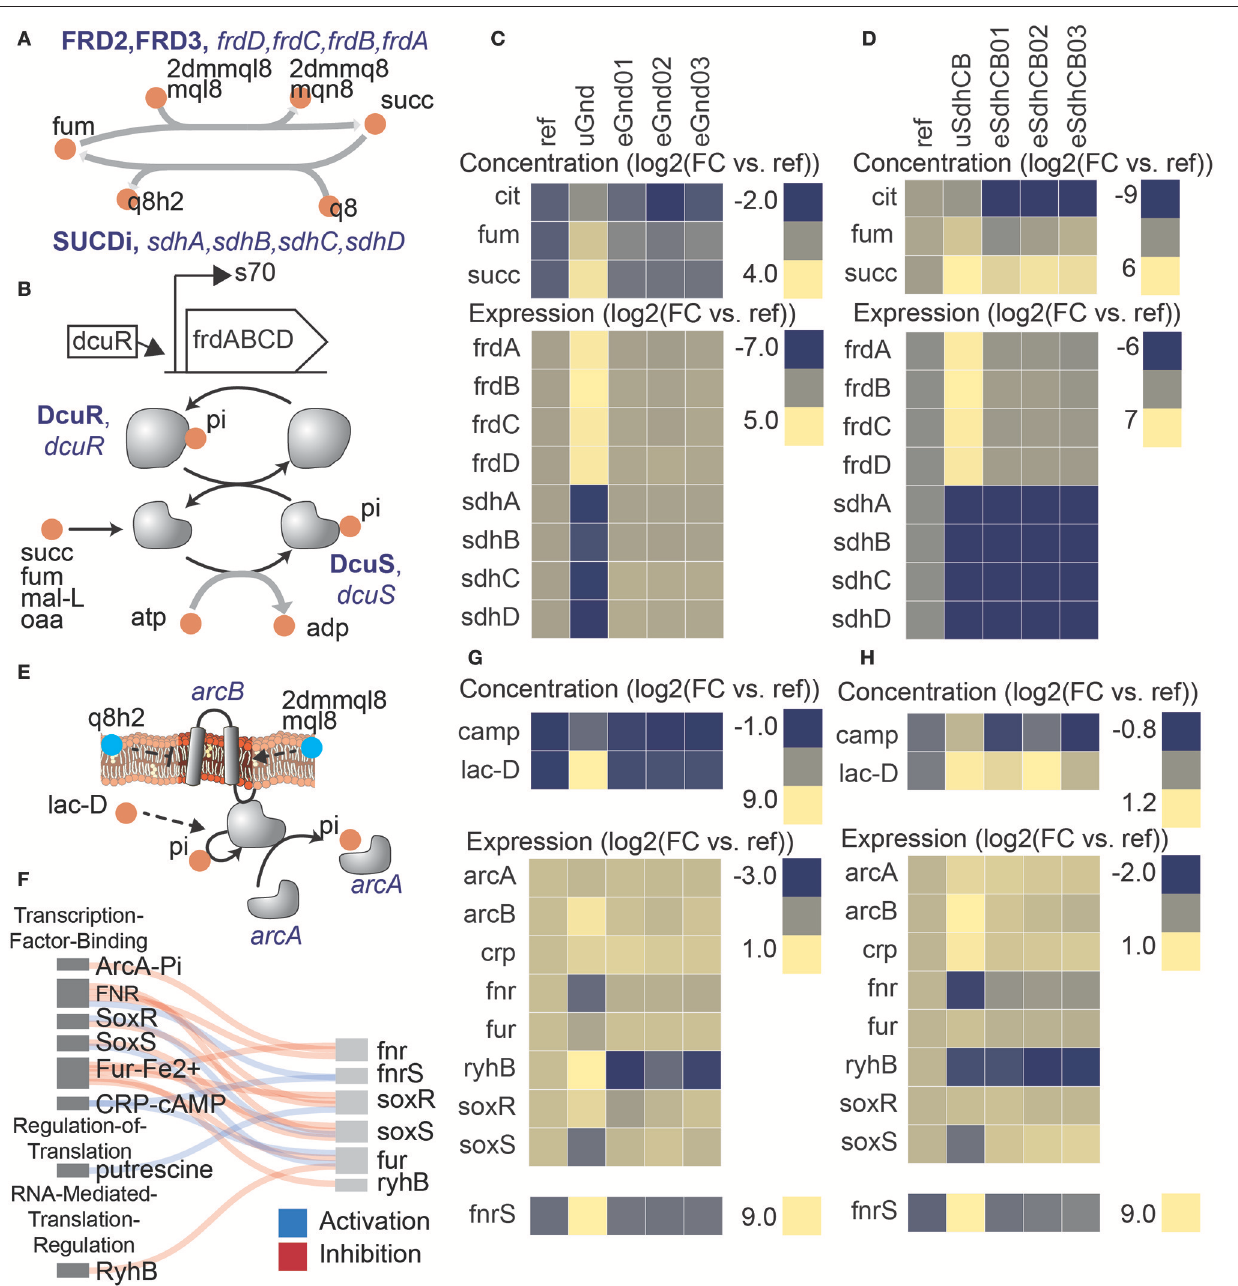
FIGURE 3 | Perturbations in separate network locations yielded similar expression states in the uKOs due to similar metabolite levels. Removal of the succinate dehydrogenase complex (sdhCB), which decoupled the TCA cycle from oxidative phosphorylation, and removal of 6-phosphogluconate dehydrogenase (gnd), which re-routed flux through upper glycolysis, the ED pathway, and the pentose phosphate pathway (PPP), resulted in similar expression profiles of TCA cycle genes as a result of increased levels of intracellular four-carbon acids (A–D) . (A) Reactions catalyzed by succinate dehydrogenase (SUCDi) and fumarate reductase (FRD2, FRD3) in the TCA cycle. (B) Schematic of the frd operon and regulation by DcuR. Also shown is a schematic of the dcuRS two component system (Janausch et al., 2004). Elevation in four-carbon acids (e.g., succinate, fumarate, malate, and oxaloacetate) were detected by the dcuRS two-component system in the uKO strains. Phosphorylated DcuR activated expression of the fumarate reductase operon genes. Metabolite levels of fumarate (fum), succinate (succ), and citrate (cit), and expression levels of fumarate reductase ( frdA , frdB , frdC , frdD ) and succinate dehydrogenase ( sdhA , sdhB , sdhC , sdhD ) genes for gnd (C) and sdhCB (D) . The similar metabolite levels in the uGnd and uSdhCB activated a network response that resulted in the upregulation of frdABCD genes in uGnd and uSdhCB, and downregulation of sdhABCD genes in uGnd. De-coupling of the TCA cycle from oxidative phosphorylation triggered an attenuated anaerobic response in gnd and sdhCB that involved a complex interaction of TFs ArcA, CRP, SoxR, SoxS, Fur, and Fnr, and small RNAs fnrS and ryhB (E–H) . (E) Regulatory schematic of the signal